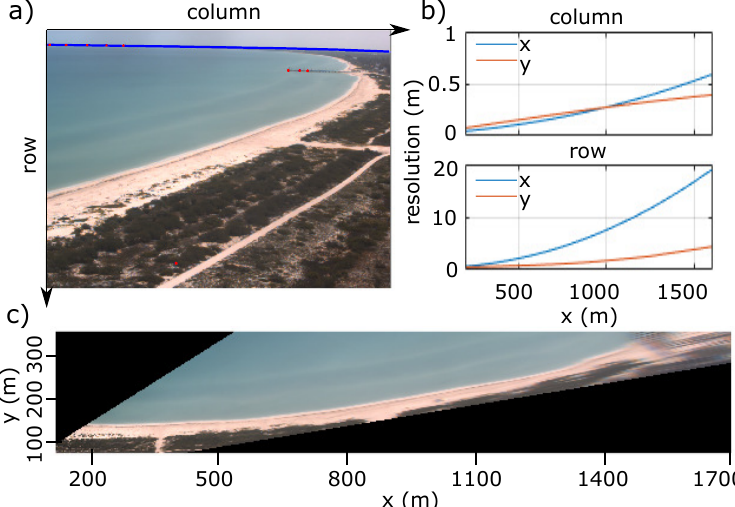
Figure 4. Camera view with red points indicating the position of 4 ground control points and 5 horizon points ( a ), resolutions resulting from the calibration process ( b ), and planview image of 2018/08/12 ( c